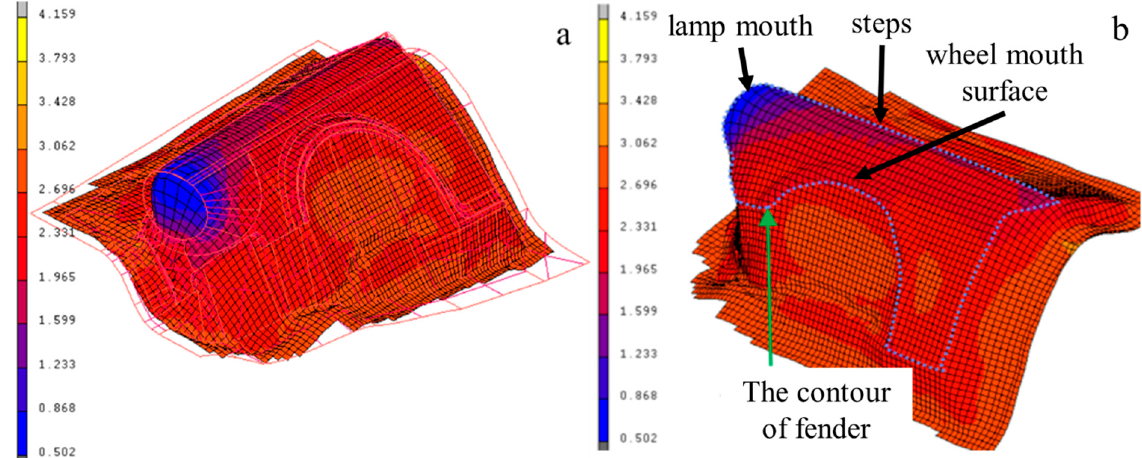
Figure 8. ( a ) Thickness distribution of the direct superplastic bulging; ( b ) contour of the fender.